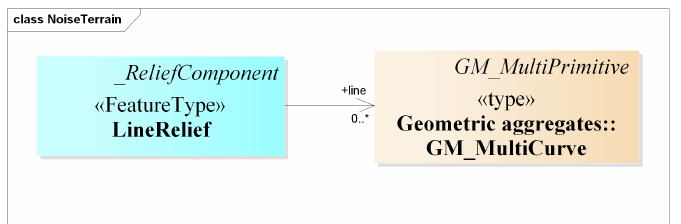
Figure 4. UML model for the LineRelief representation added to the CityGML Relief module to represent the terrain as height lines in